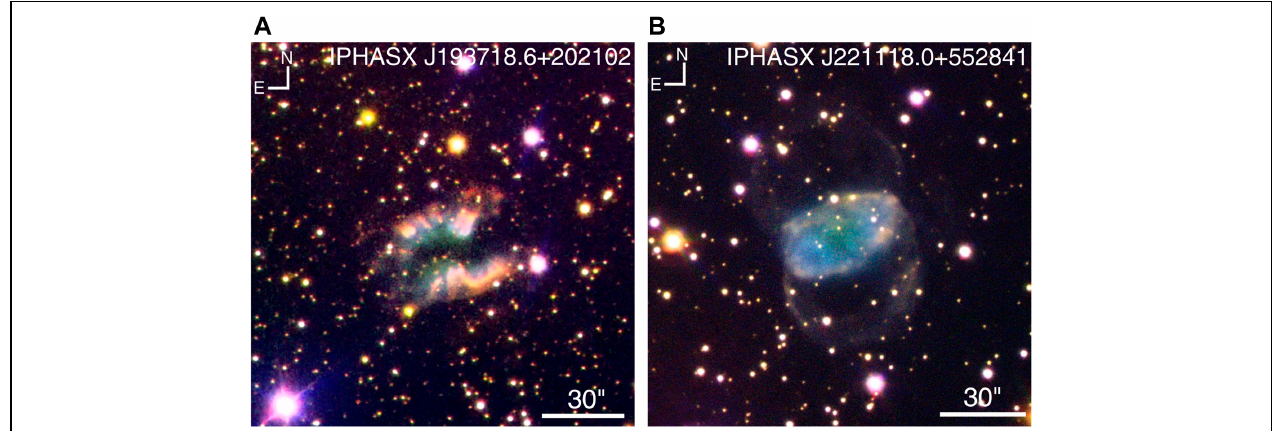
FIGURE 1 | Nordic Optical Telescope RGB-composite pictures of the IPHAS sources IPHASX J193718.6+202102 (A) and IPHASX J221118.0+552841 (B) , respectively, where the color red was assigned to the [N II] λ c = 6,583 Å,green for the H α λ c = 6,563 Å,and blue for the [O III] λ c = 5,007 Å filters. Faint bipolar lobes are barely visible in IPHASX J221118.0+552841 at the north and south of the main nebula, while IPHASX J193718.6+202102 was extensively studied by Sabin et al. (2021b), reporting chemical abundances typical of Type II PNe.